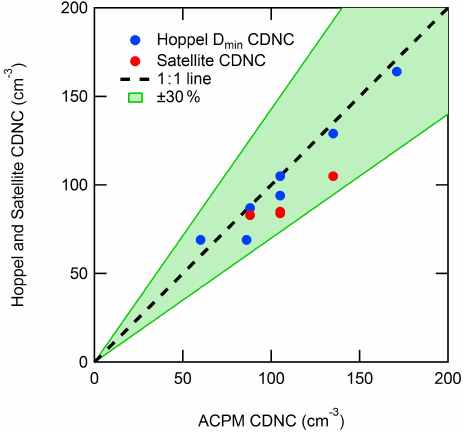
Figure 6. Comparison of simulated CDNC from ACPM with both Hoppel minimum diameter ( D min ) derived CDNC (blue) and satellite-estimated CDNC (red). CDNCs plotted are from the listed cloud cases in Table 2. The green shaded region represents Hoppel and satellite CDNCs within 30% of ACPM simulation